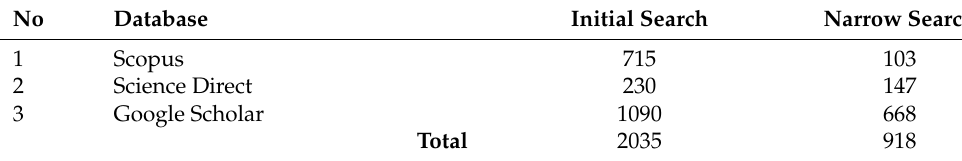
Table 1. Initial and narrow search of relevant studies.